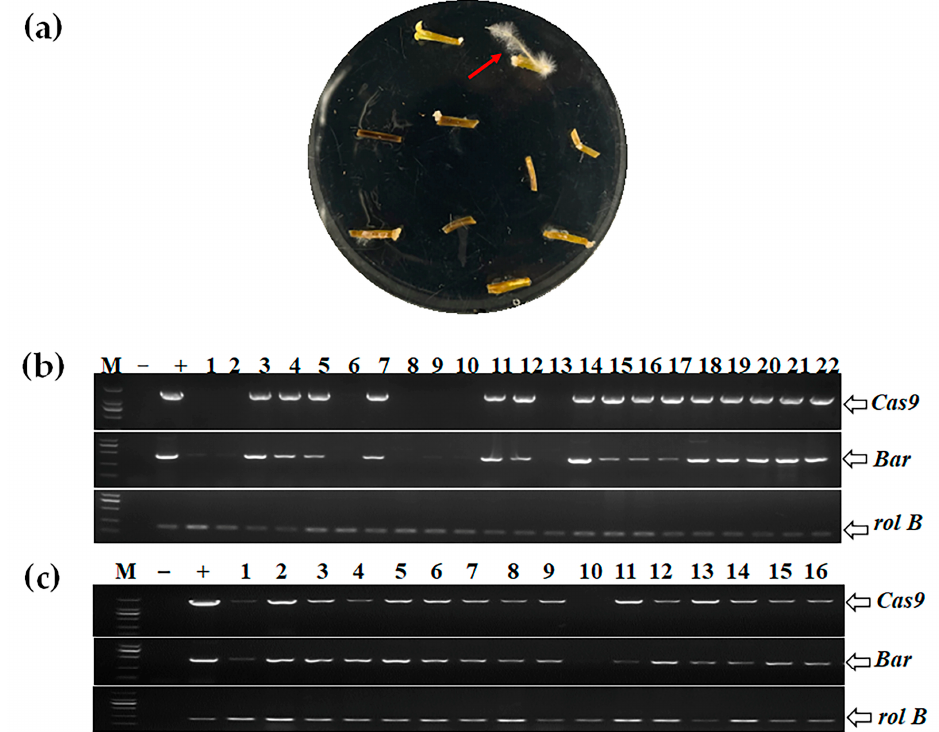
Figure 2. PCR analysis for identification of T-DNA transformed spinach hair roots. ( a ) Hairy roots appeared after 10–20 days of infection. ( b , c ) Identification of transgene hairy root lines of SoCSLD3 ( b ) and SoCSLD3 ( c ) by genome PCR screening. Untransformed roots served as a negative control, and A. rhizogenes strain LBA9402 harboring the CRISPR/Cas9 plasmid was used as a positive control. The expected band sizes of the Bar , Cas9 , and rol B were marked by arrows.